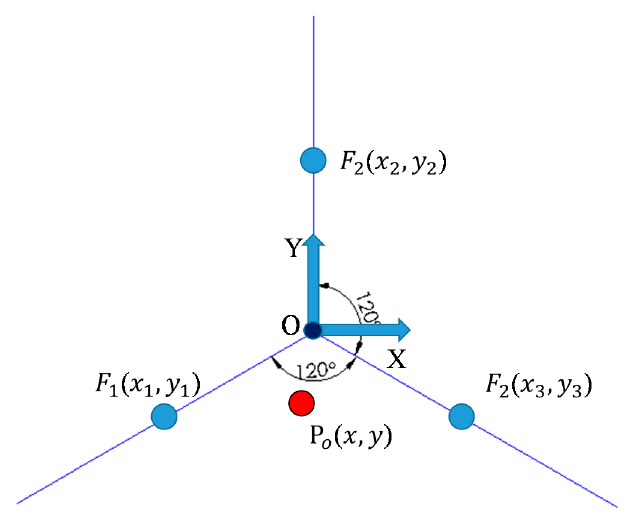
Figure 3. Schematic of the distribution of the resultant pressing force.